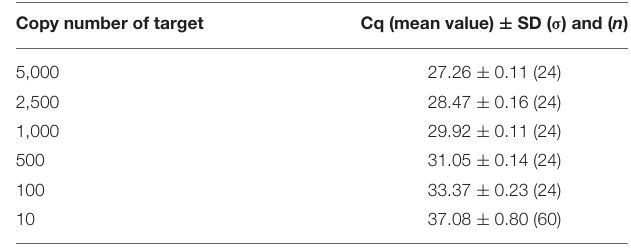
TABLE 8 | Cq values obtained on dilutions of genomic material used for efficiency calculation and for LOD 95 % .